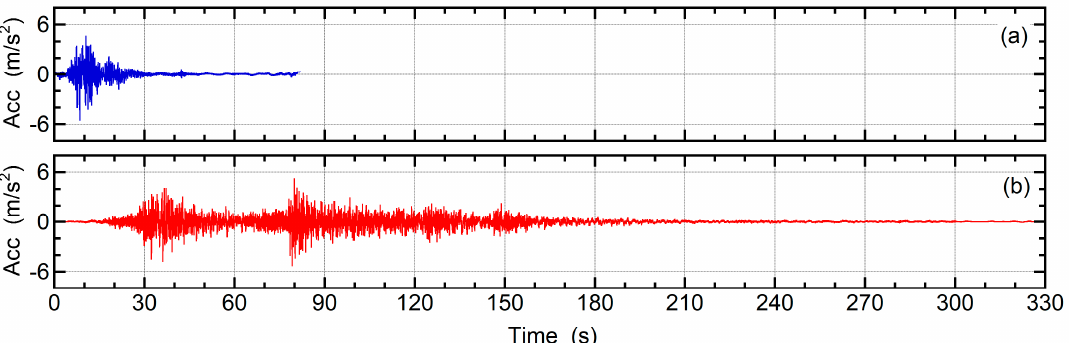
Figure 8. Example waves of the generated artificial ground motions: ( a ) Art-S00; ( b ) Art-L00.